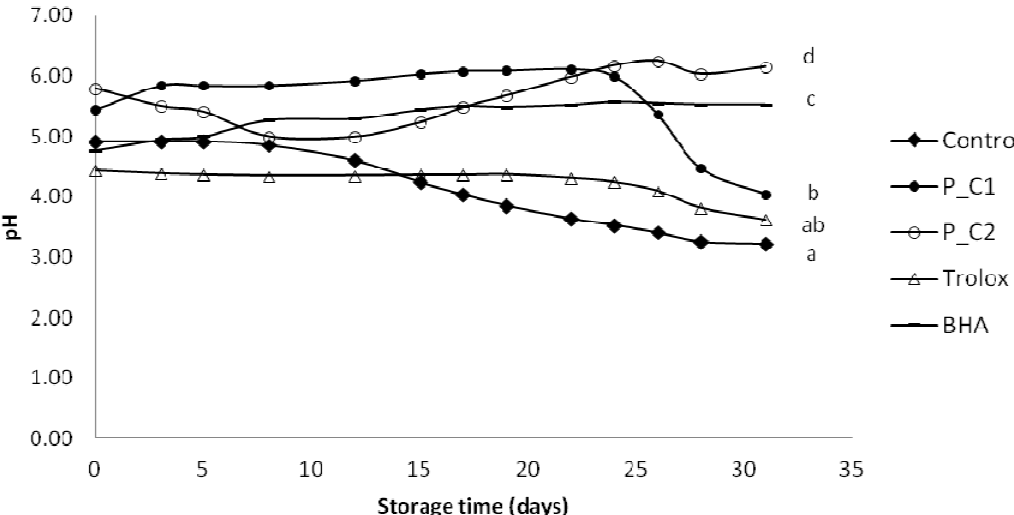
Figure 2. Evolution of pH in model food system (O/W emulsion 10% of oil) with different concentration of perilla ethanolic extracts (C1: 80 ppm and C2: 320